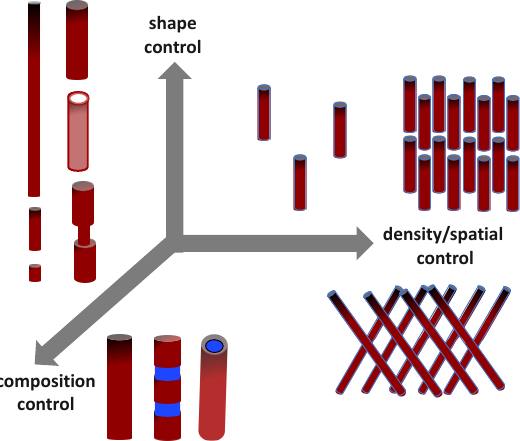
Figure 1. Illustration of the versatility of the template-assisted synthesis of